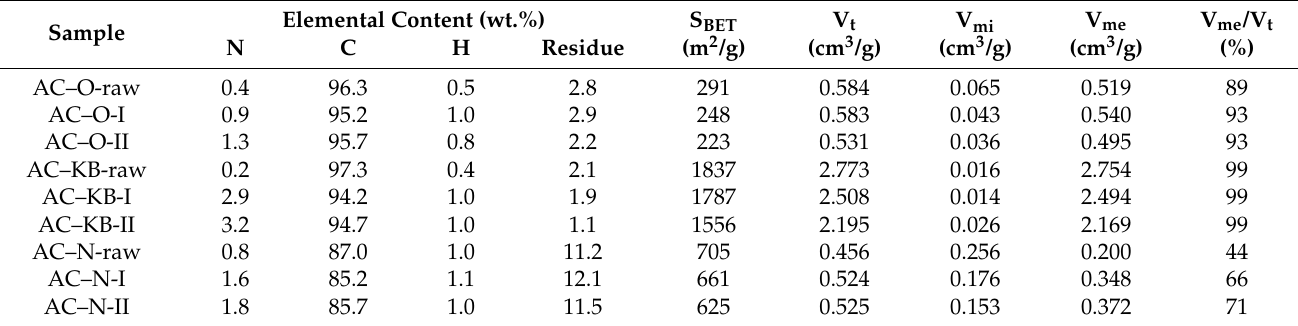
Table 2. The chemical composition and structural parameters of the obtained N-doped activated carbons and raw materials.